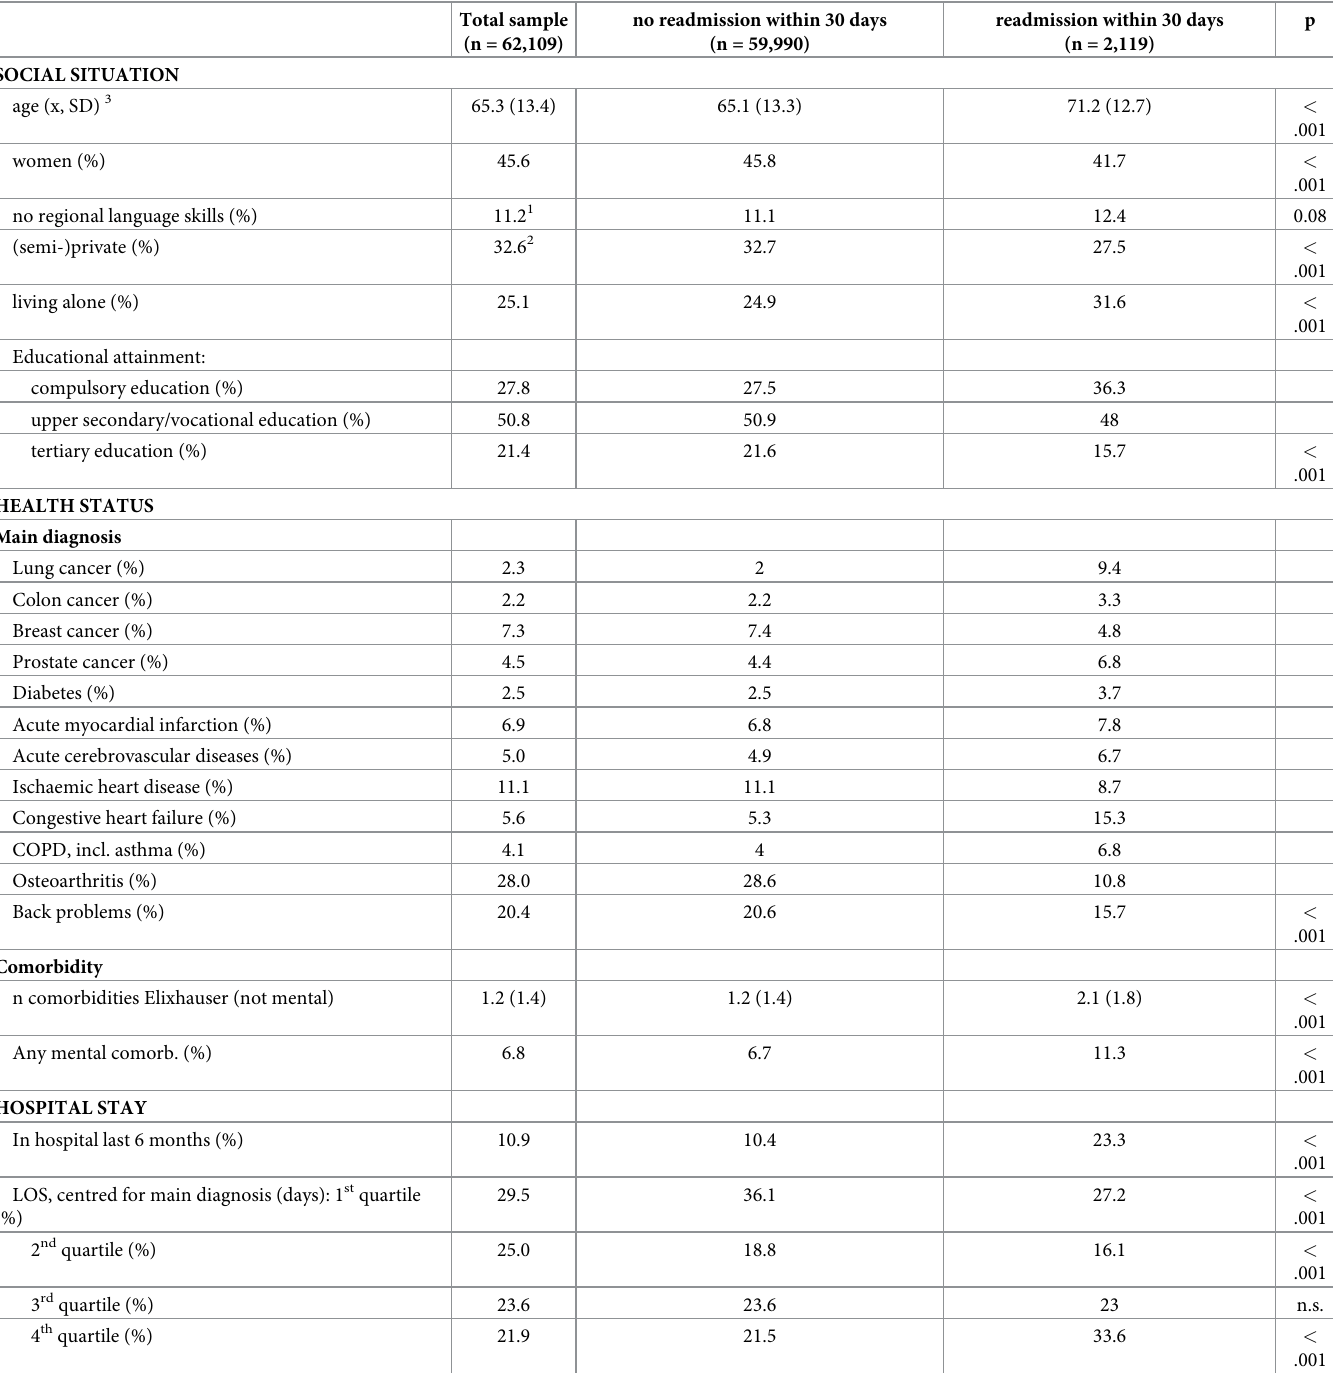
Table 2. Characteristics of patients with/without unplanned 30-day readmission: Demographic, social, health status and hospital